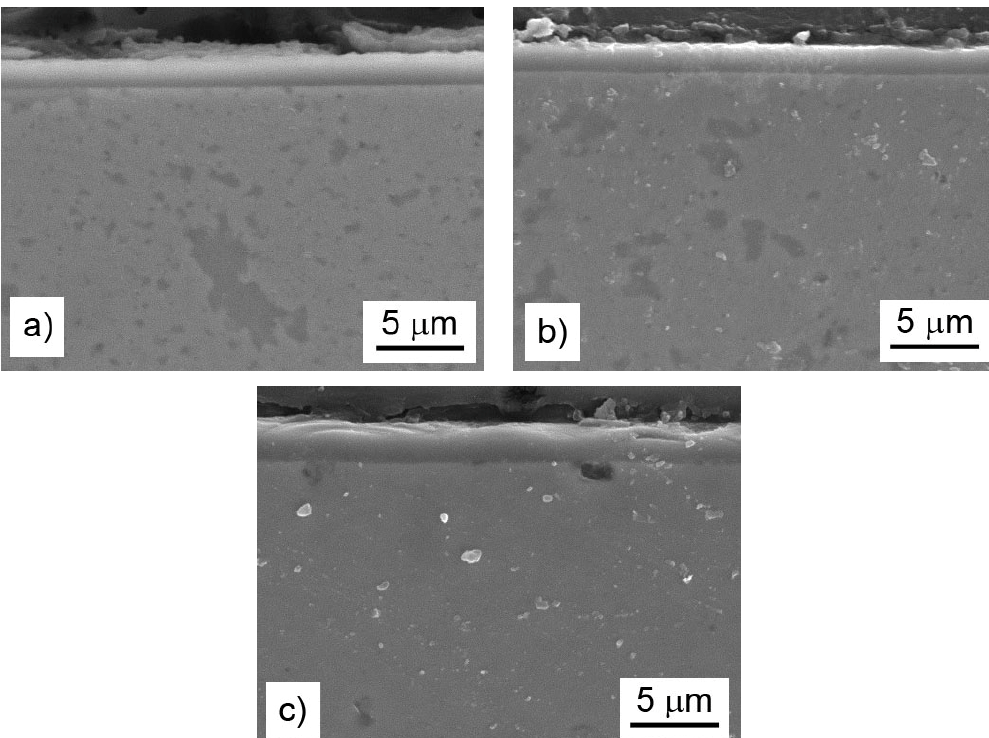
Figure 10. Microstructure (secondary electrons (SE)-SEM) of the oxide layers on the bulk alloys after cyclic oxidation at 800 °C for 400 h in air: the FeAl35Si5 alloy ( a ), the FeAl35Si5Ni20 alloy ( b ), and the FeAl35Si5Ti20 alloy ( c ). Table 5. Chemical composition of the oxide layers (EDS).